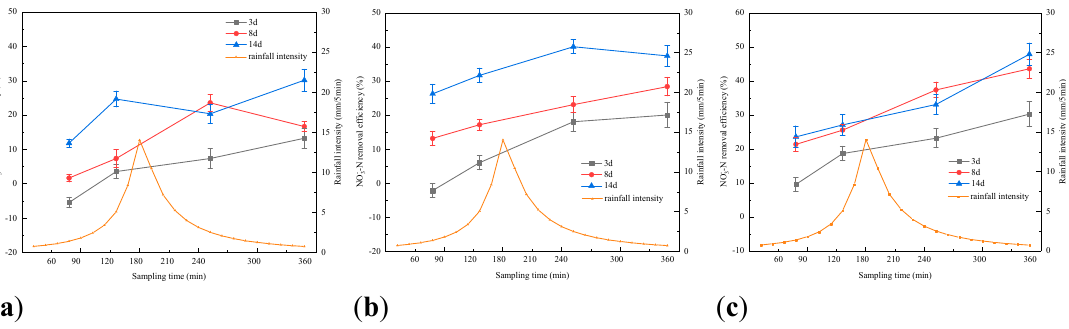
Figure 8. The efficiency of NO 3- -N removal using bioretention systems with the ( a ) Control column, ( b ) DS column, and ( c ) SZ column during different antecedent dry periods.